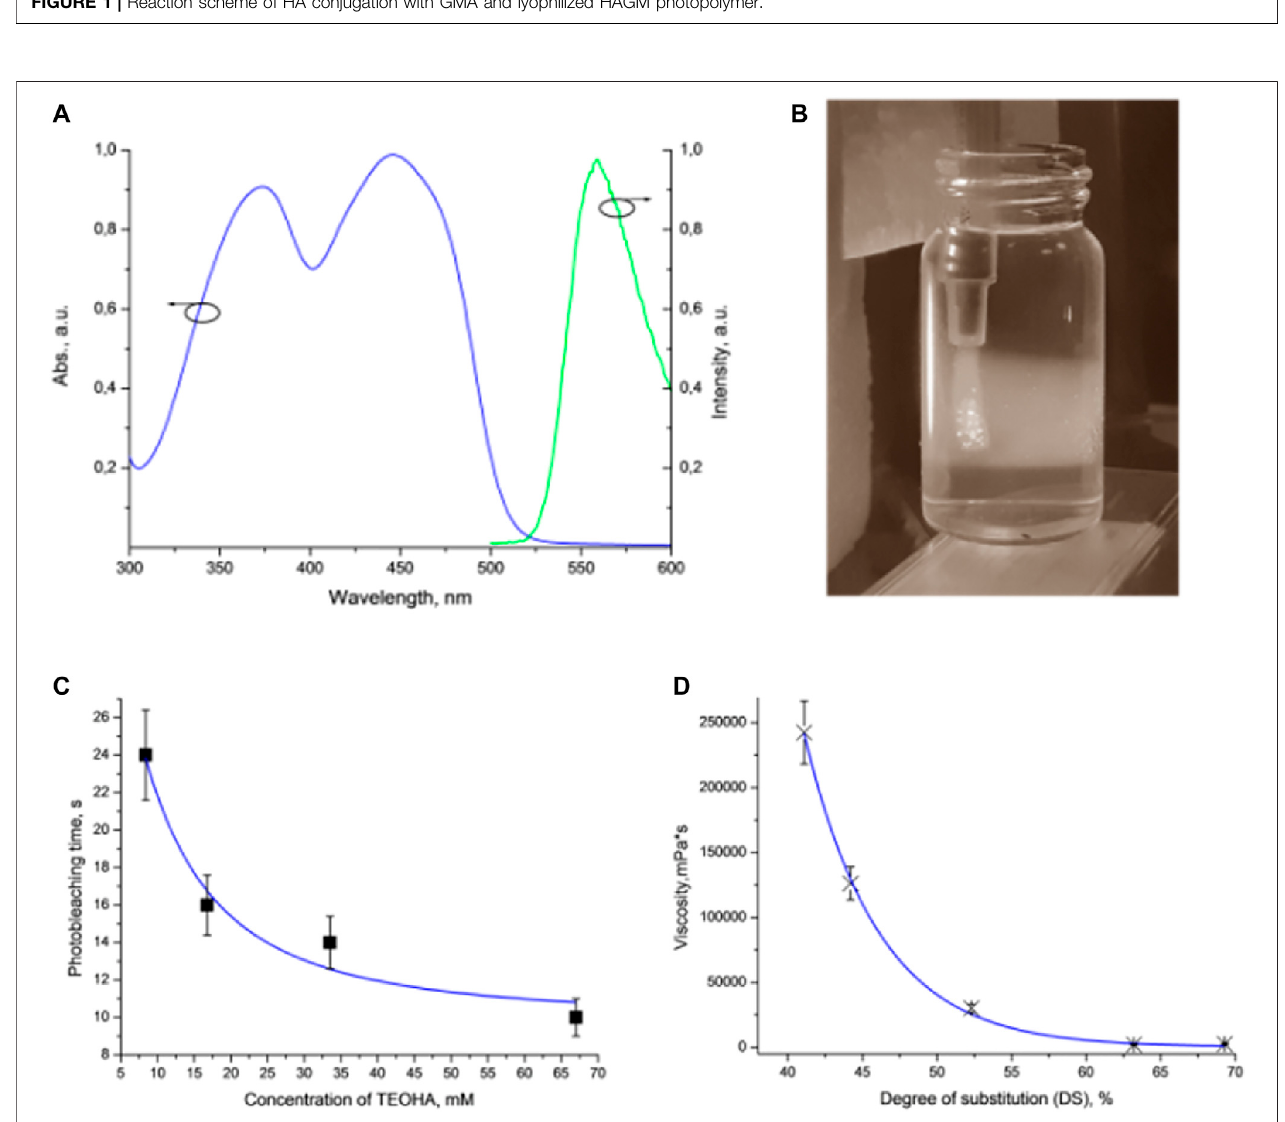
Frontiers in Bioengineering and Biotechnology |